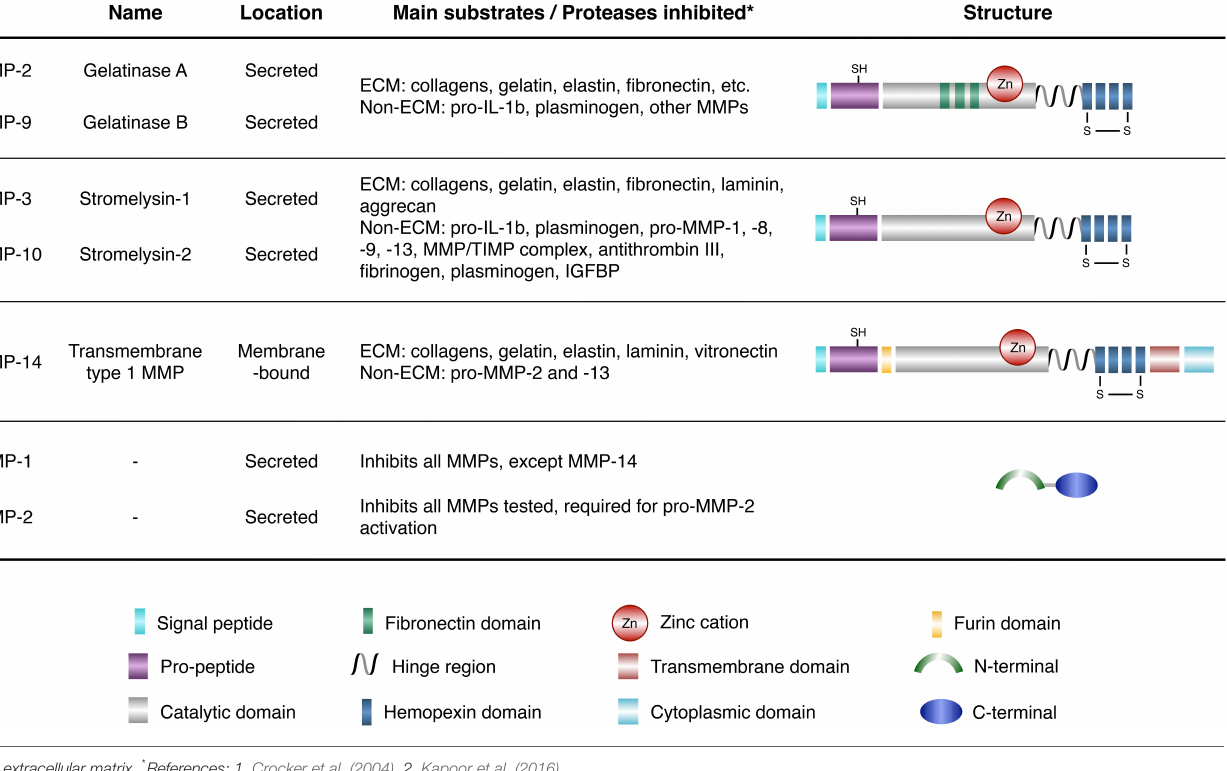
TABLE 1 | Classification of MMPs and TIMPs.